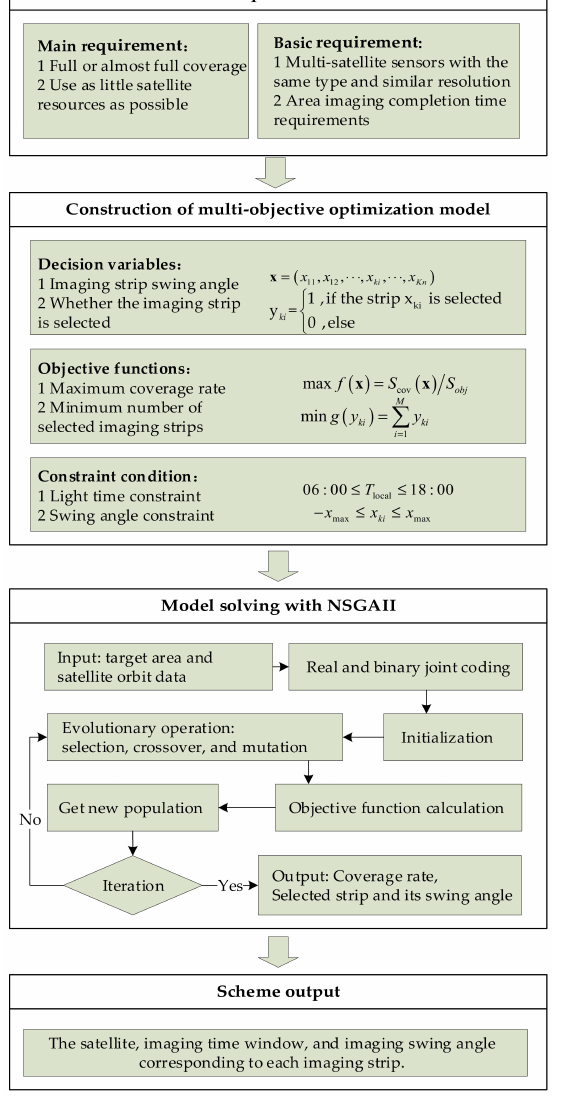
Figure 2. Flowchart of the multi-satellite mission planning scheme for large-area